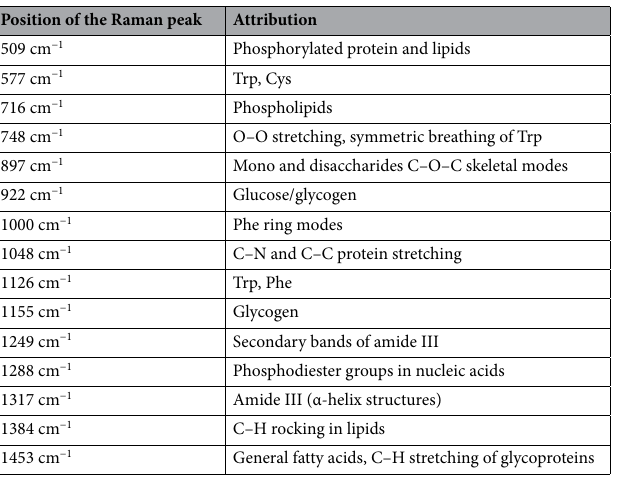
Table 2. Attribution of the most prominent signals revealed from the Raman salivary analysis (± 5 cm −1 ). Based 26,28,30,38–40 . Trp tryptophan, Cys cysteine, Phe